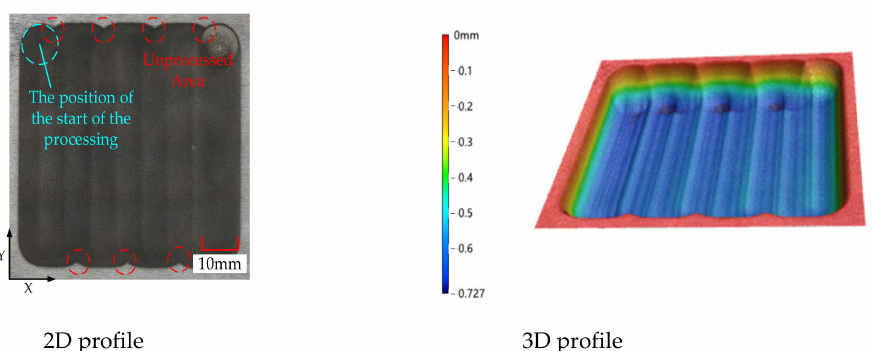
Figure 14. Diagram of electrochemical milling of a flat surface.